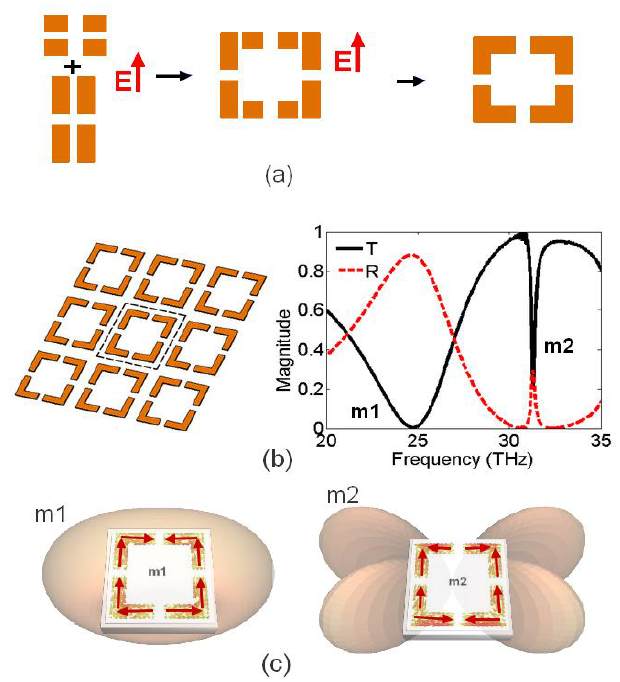
Figure 2. ( a ) The transformation from an 8-gap-multi-gap split ring resonator (MSRR) and its corresponding equivalent resonators under a linearly polarized incident wave to the 4-gap MSRR with four-fold symmetry. ( b ) Schematic view of the metamaterial composed of an array of metallic MSRRs (left) and Transmission and reflection spectra of the MSRR (right). ( c ) Cartographies of the surface current and the radiation patterns of the MSRR at the two first resonances.